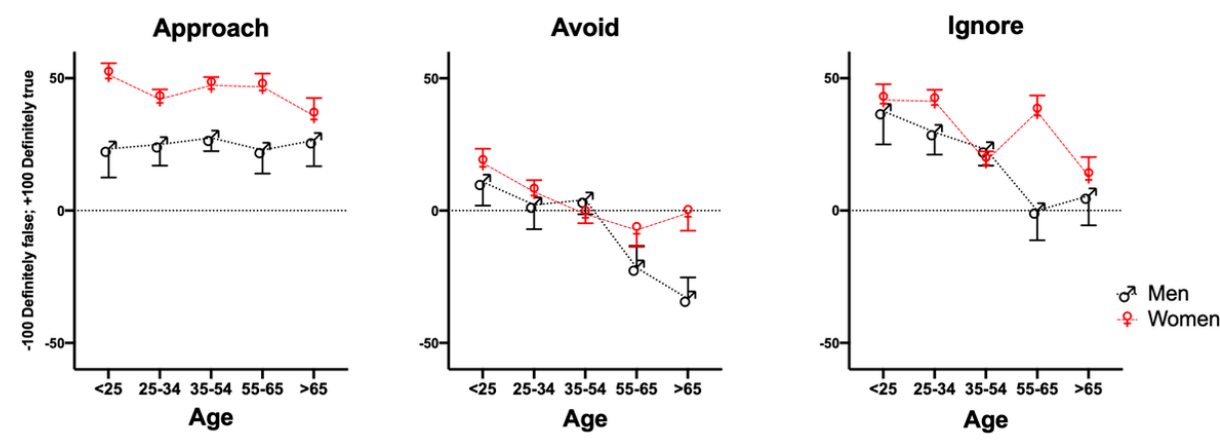
Figure 4. Age- and gender-related differences in appraisal (mean, standard error of the mean).